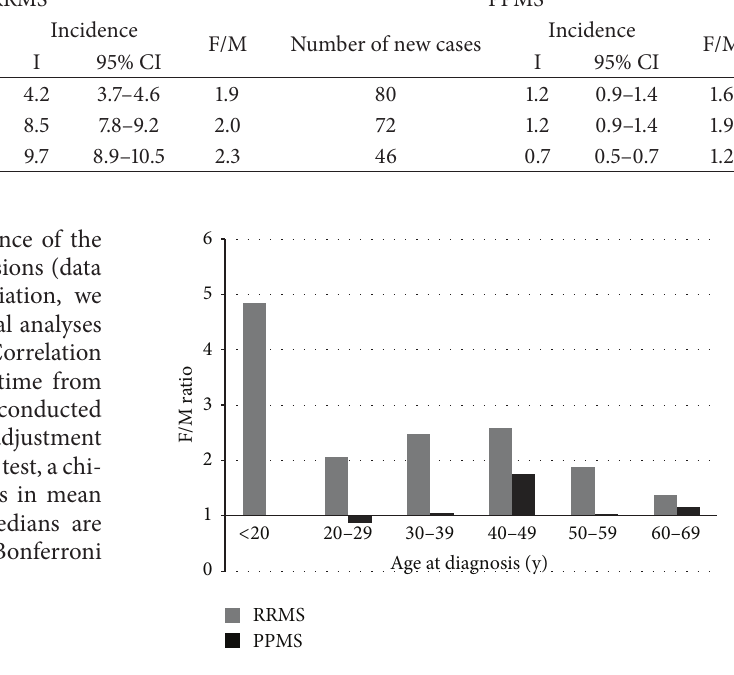
Table 1: Age-adjusted incidence of RRMS and PPMS per 10 5 person-years with 95% CIs and F/M ratios from 1981 to 2010 in ten-year periods. Disease course